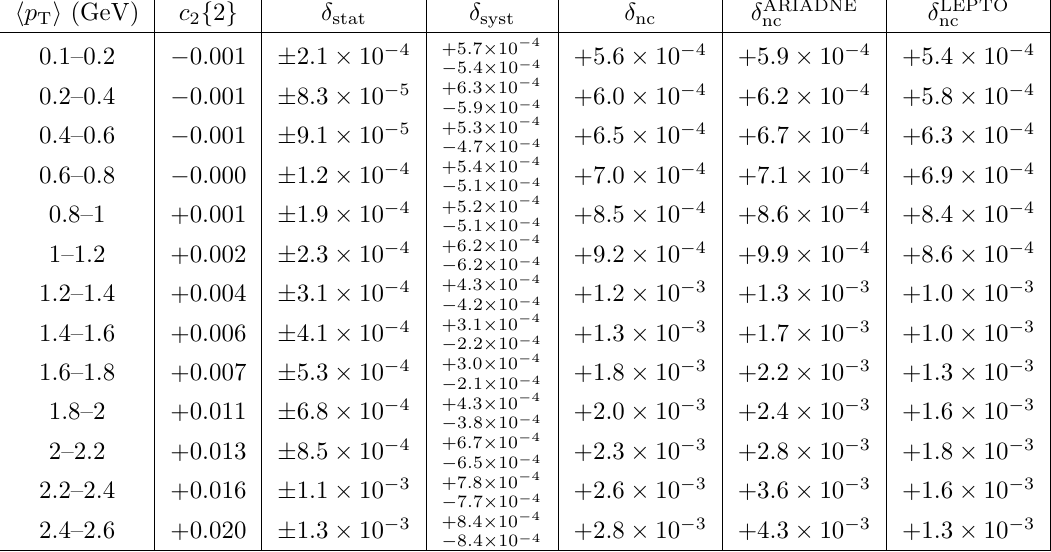
Table 24 . c 2 f 2 g versus h p T i from (cid:12)gure 9 (b), 5 (cid:20) N ch (cid:20) 10, p T > 0 : 1 GeV, j (cid:1) (cid:17) j > 2; (cid:14) stat , (cid:14) syst and (cid:14) nc denote the statistical, systematic and Monte Carlo non-closure uncertainties, respectively.